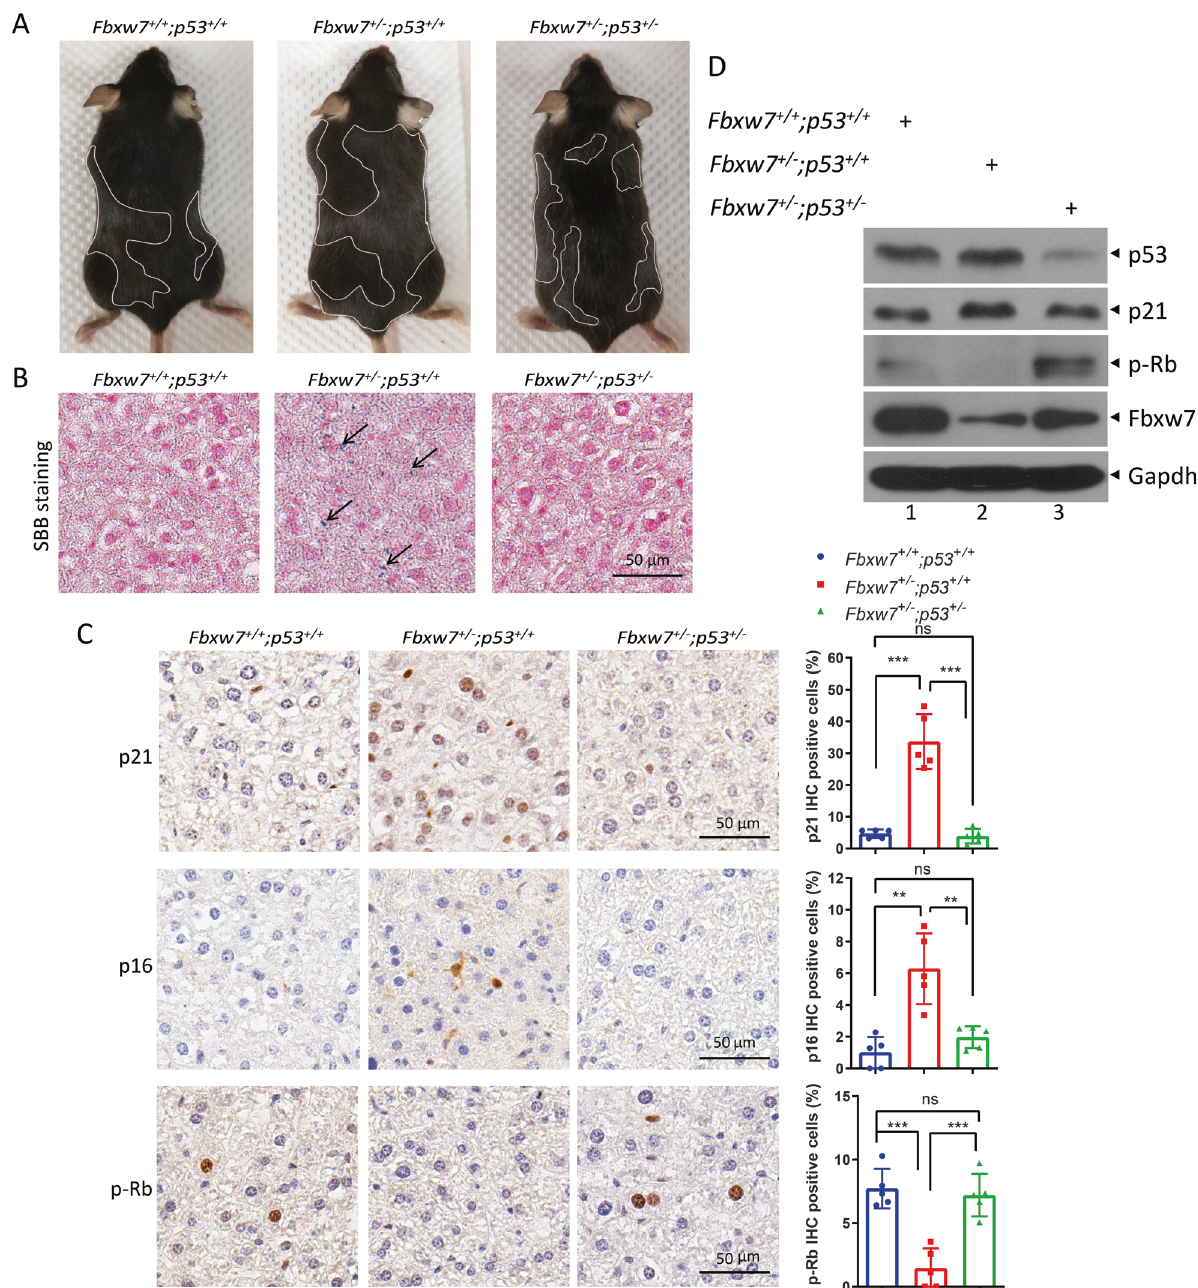
Fig. 4 FBXW7 deletion promotes senescence in a p53-dependent manner in vivo. Three littermate mice with the indicated genotypes were exposed to 7 Gy irradiation and maintained for 3 months, followed by being photographed ( A ). Liver tissues of mice were harvested and subjected to SBB staining ( B ), immunohistochemistry (IHC) ( C left), or IB with the indicated antibodies ( D ). The area of graying hair is circled by a white line. The percentage of staining-positive cells in the total number of cells was determined from at least fi ve random fi elds of liver tissues ( C right). ** p < 0.01; *** p < 0.001; ns not signi fi cant. Scale bars represent 50 μ